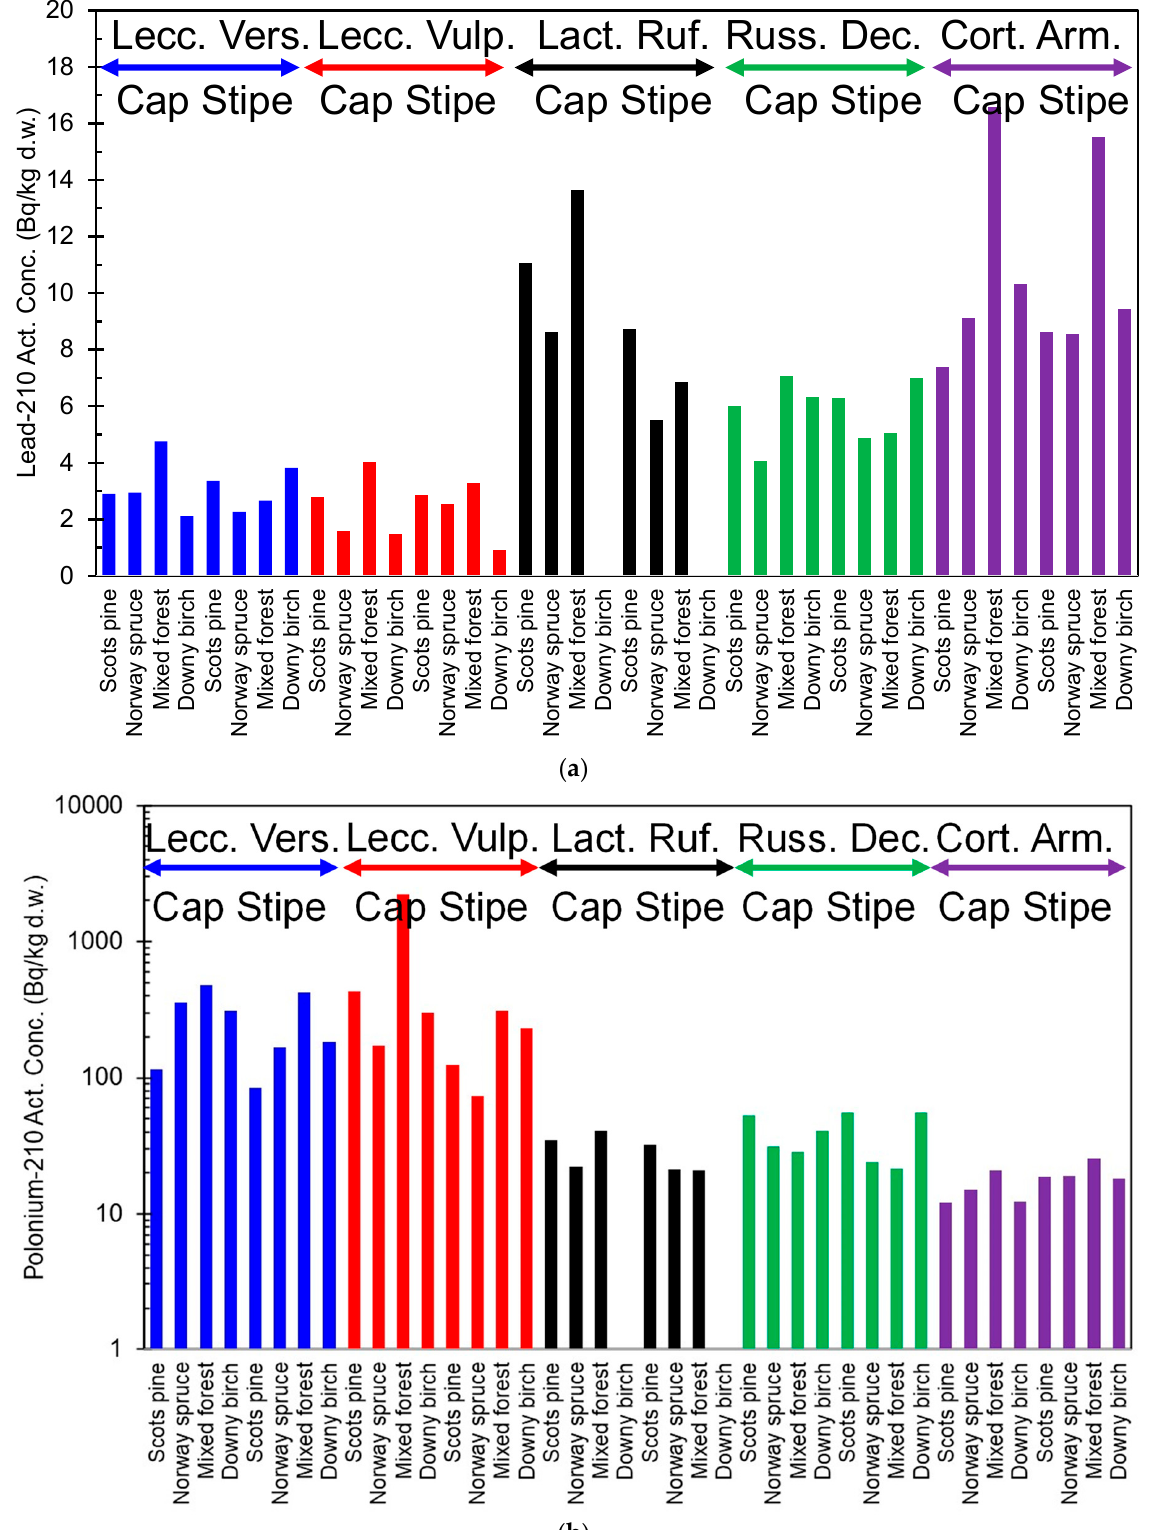
Figure 2. ( a ). 210 Pb activity content of different mushroom species (blue = Leccinum Versipelle, red = Leccinum Vulpinum , black = Lactarius Rufus, green = Russula Decolorans , and purple = Cortinarius Armillatus ) in northern Finland, from the data in [17]. ( b ). 210 Po activity content of different mushroom species (blue = Leccinum Versipelle, red = Leccinum Vulpinum, black = Lactarius Rufus, green = Russula Decolorans , and purple = Cortinarius Armillatus ) in northern Finland, from the data in